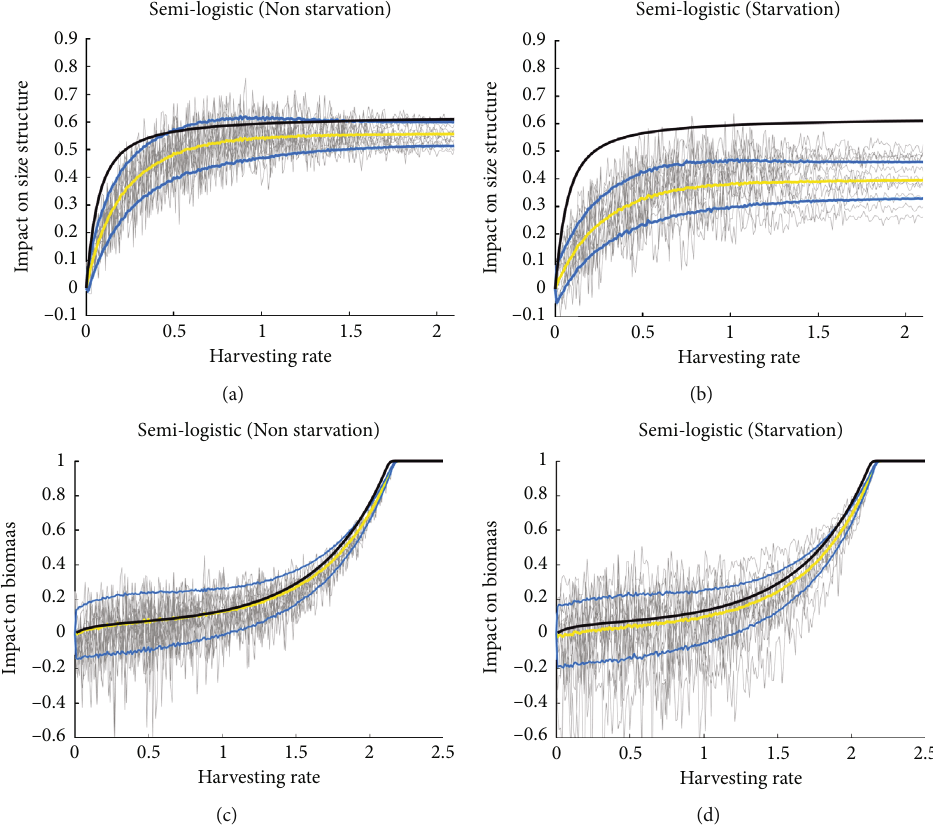
Figure 8: Impact on size structure and biomass of threshold-logistic growth rate without starvation (a, c) and with starvation (b, d) at steady state w.r.t. harvesting rate. The grey trajectories show the impact on size structure and biomass from di ff erent simulations for the stochastic case. The yellow curve represents the mean value of the simulations. The light blue curves represent the interval of standard deviation (68%). The black curve represents the impact on size structure and biomass for the deterministic case. Equations (17) and (18) are used to derive the above graphs for the impact on size structure and biomass,